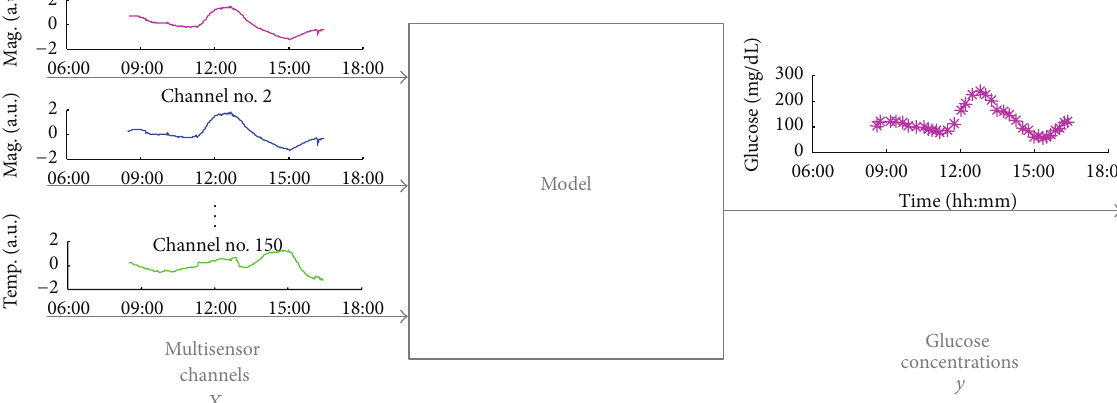
Figure 1: A model (center) is needed to properly combine the 150 multisensor channels (left, depicted with lines of different colours) for estimating blood glucose concentration profile (right, magenta